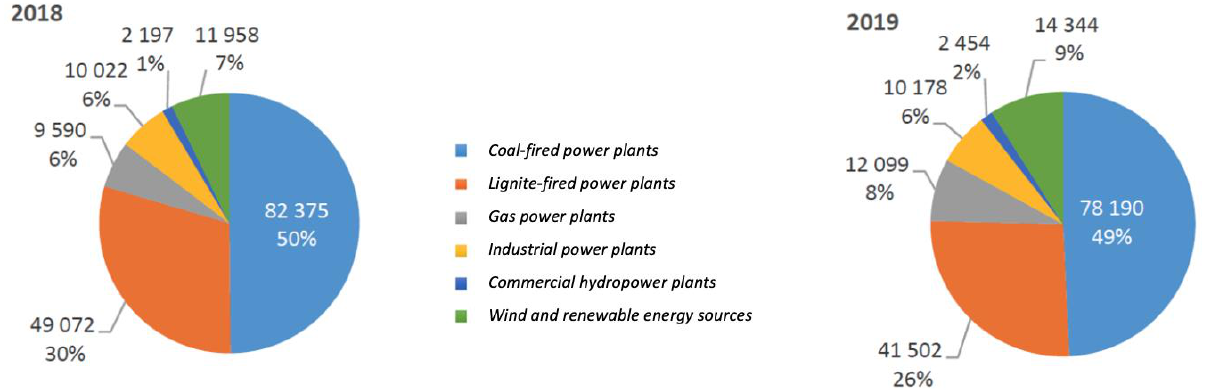
Figure 1. Energy mix — the synthetic structure of electricity production in Poland, year over year,